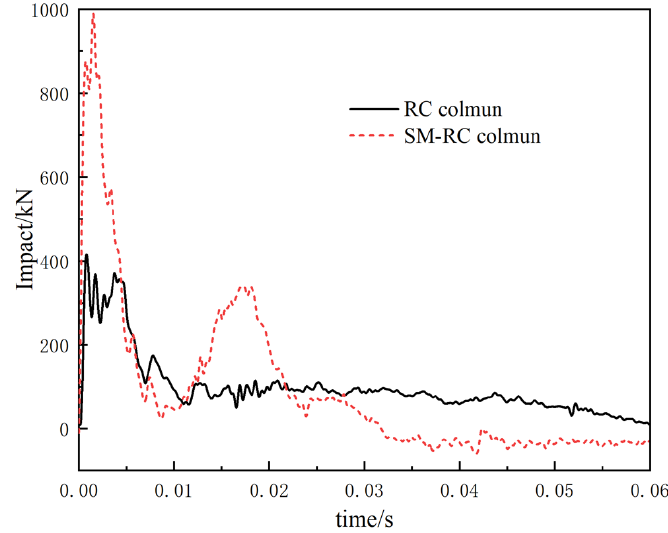
Figure 8. Impact-time history